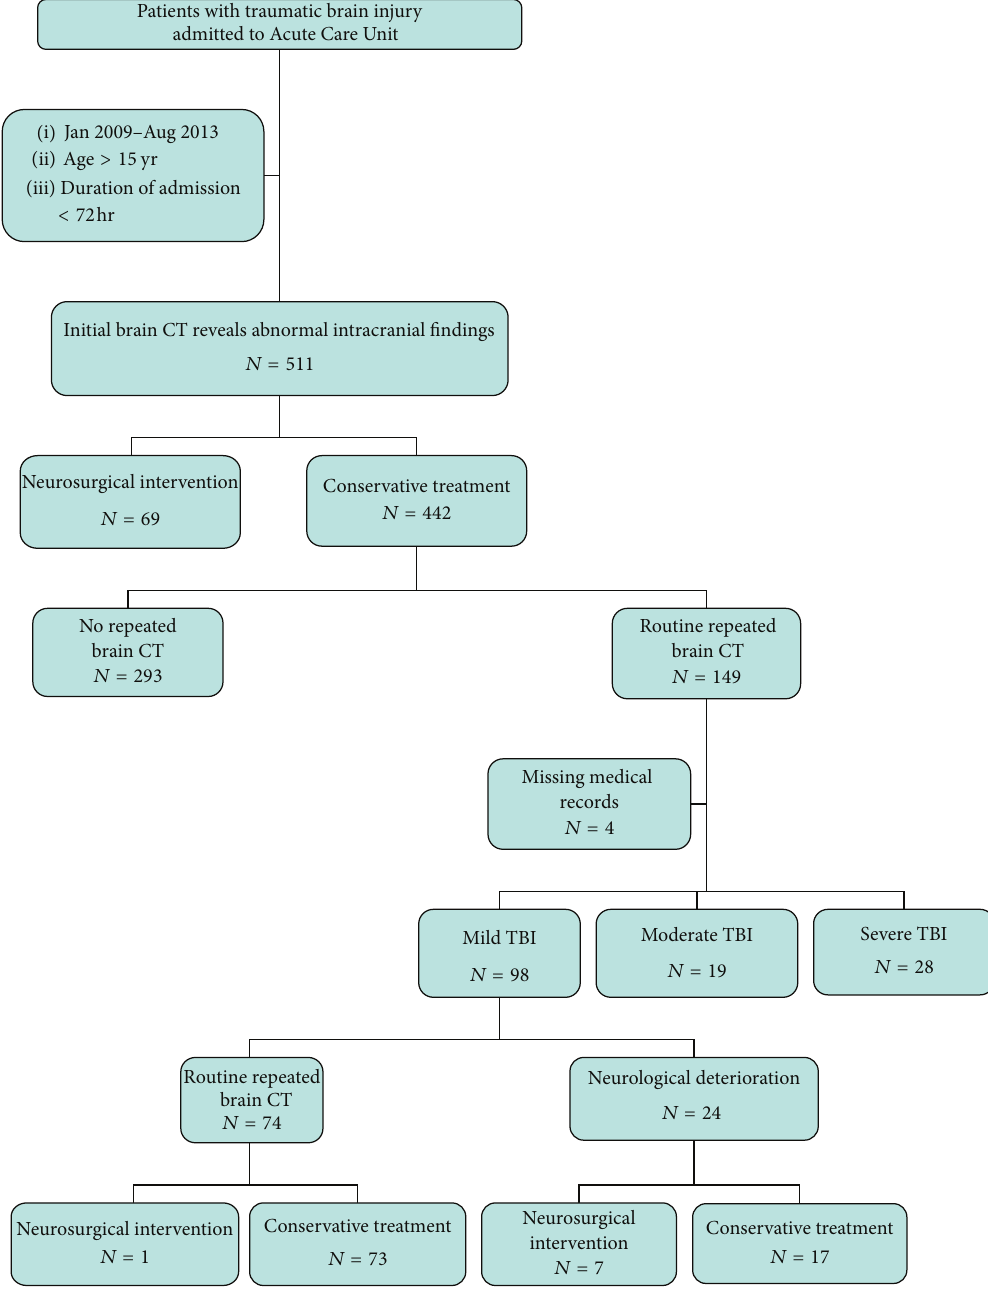
Figure 1: Study flow